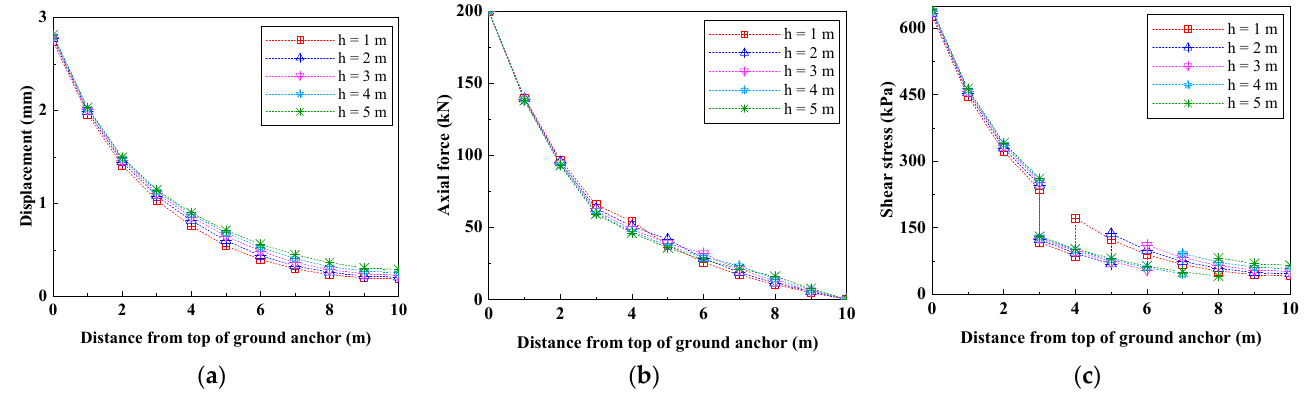
Figure 14. Effect of interlayer thickness change on mechanical behavior of ground anchor. (Case 2: condition 5) ( a ) displacement distribution curve; ( b ) axial force distribution curve; ( c ) shear stress distribution curve.